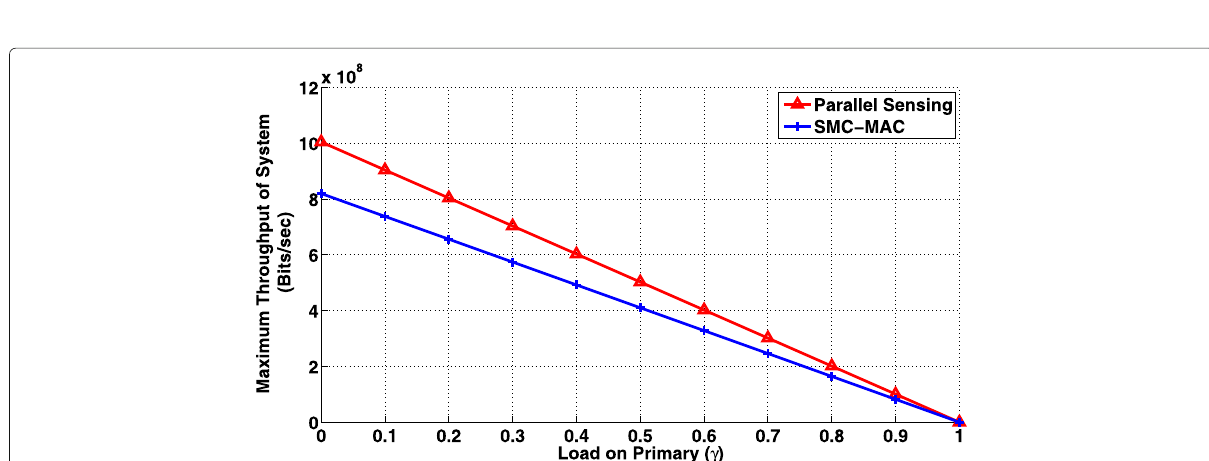
Fig. 14 Comparison of the maximum throughput of the system between parallel sensing scheme and SMC-MAC [27], with parameters N g = 10, ch max = 10, N su = 2, and N ch = 100